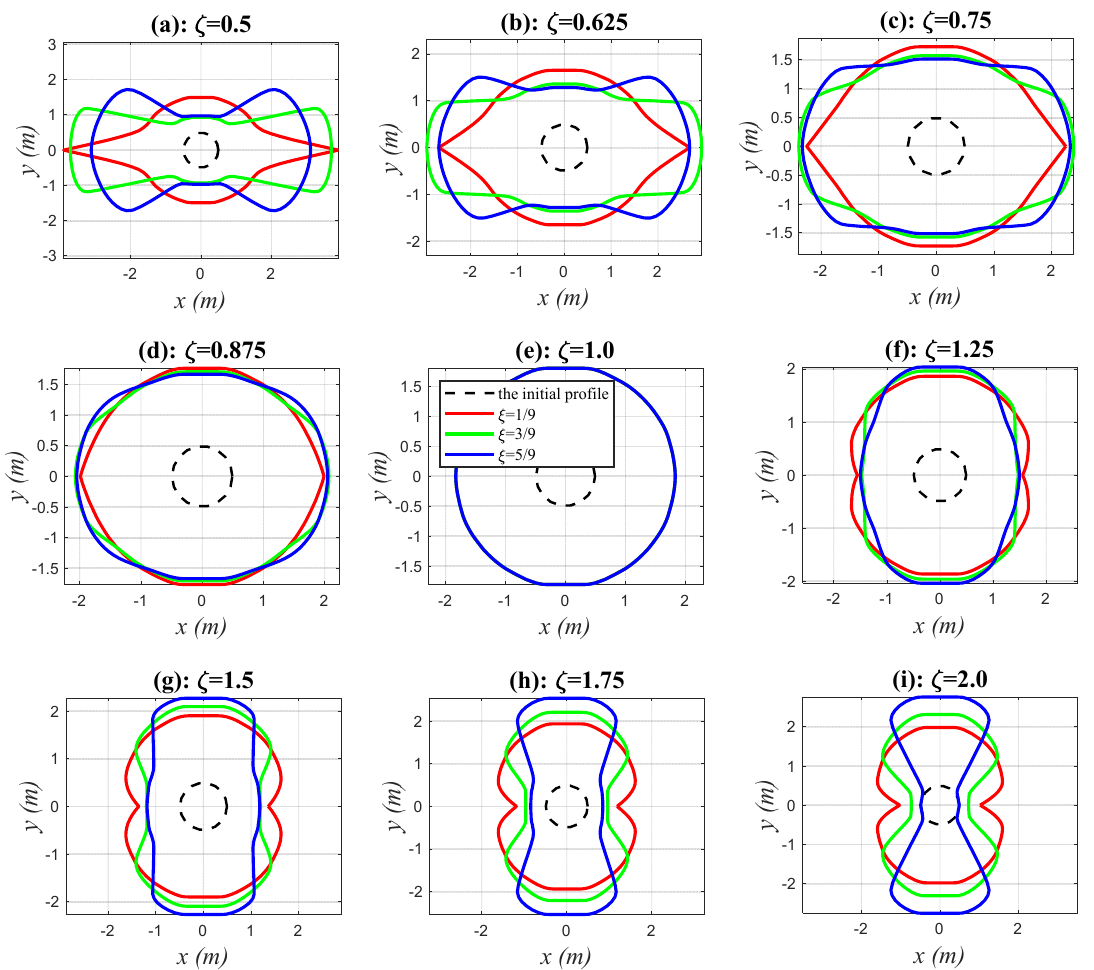
Figure 18. Comparison of fracture profiles affected by different proportions of pay zone under the same fracture toughness contrast at the moment = 20 s . The legend in the subgraph ( e ) is also applied to other subgraphs ( a )–( i ).